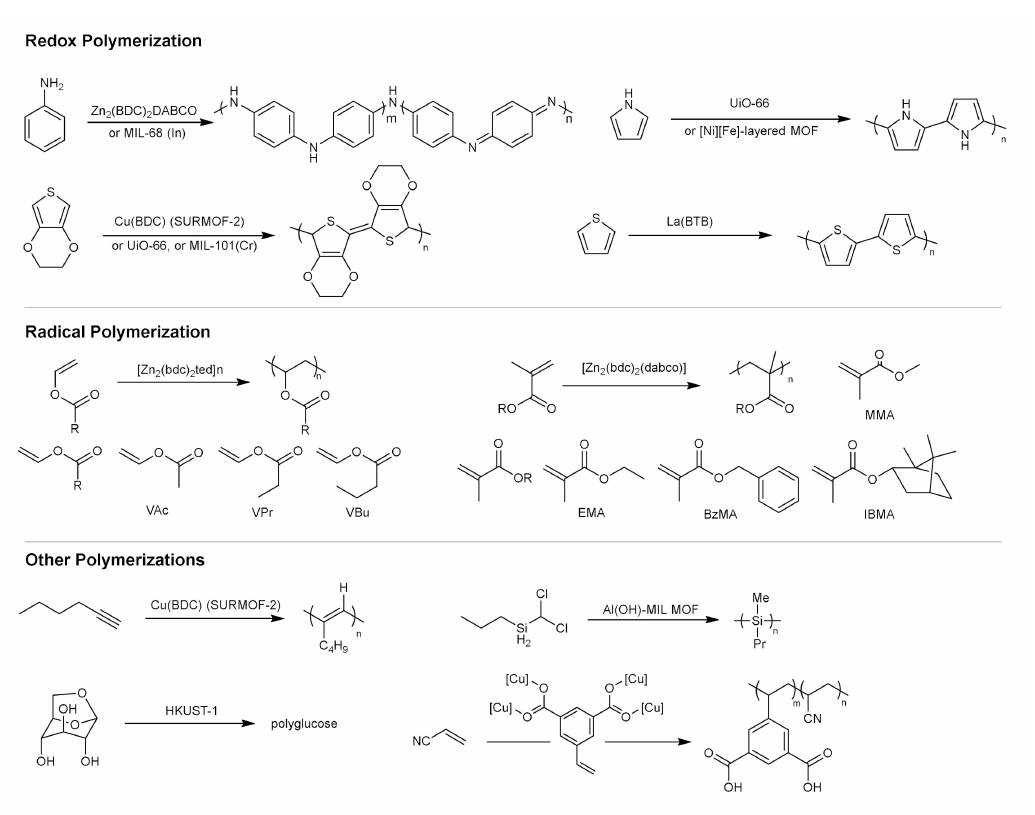
Figure 11. Summary of the polymerization reactions templated by MOFs. The types of the polymerization reactions are classified by the reaction